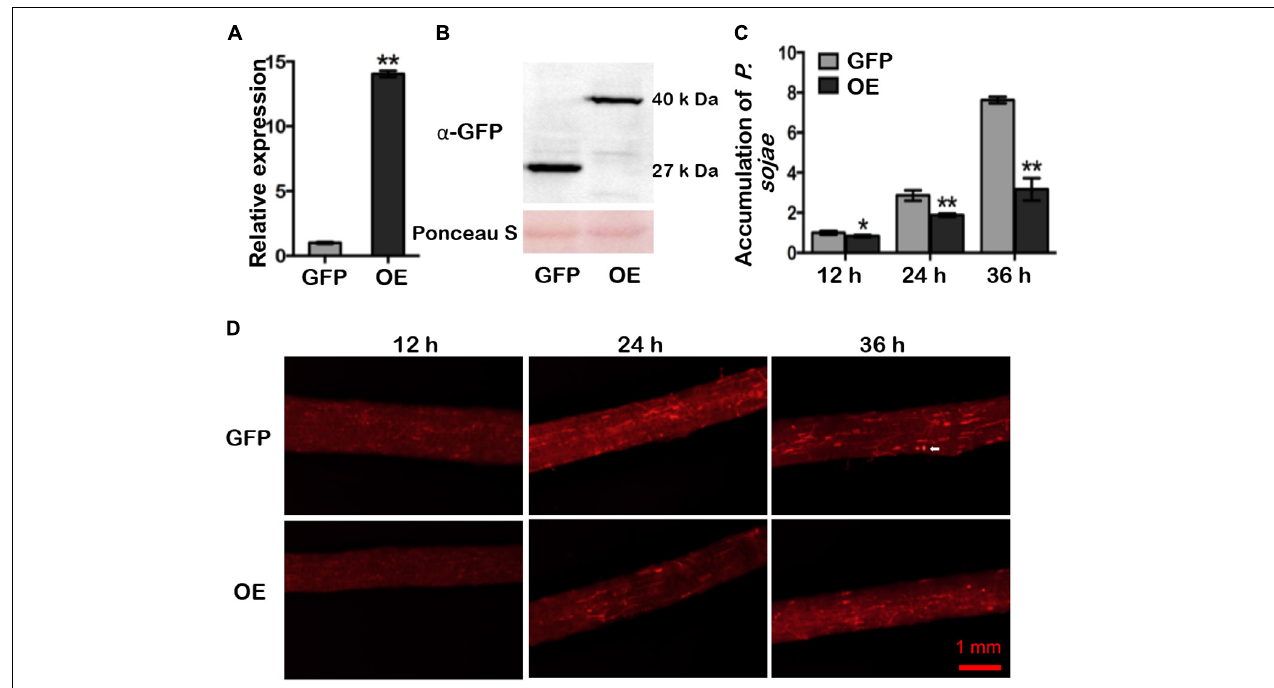
FIGURE 3 | GmDAD1 overexpression enhances resistance to P. sojae in soybean hairy roots. (A) Expression of GmDAD1 in the GmDAD1-GFP overexpressing (OE) and control ( GFP ) hairy roots without P. sojae infection. Samples derived from different pooled root materials. Control has been transformed with the empty vector which allows expression of the GFP only. (B) Western blotting of proteins from hairy roots expressing GFP (control) and GmDAD1 fused with GFP tag. (C) Relative biomass of P. sojae determined by qPCR in inoculated OE and GFP hairy roots at 12, 24, and 36 hpi. Values represent the means of three replicates and 10 hairy roots were used for each biological replicate. Data were analyzed by using Student’s t -tests ( ∗ P < 0.05, ∗∗ P < 0.01 compared with the control). (D) Microscopic analysis of P. sojae colonization in infected soybean hairy roots. The OE and control GFP hairy roots were inoculated with zoospore suspension (10 4 zoospore/ml) of the P. sojae P6497-RFP. Photos were taken at 12, 24, 36 hpi. The white arrow indicates a germinating